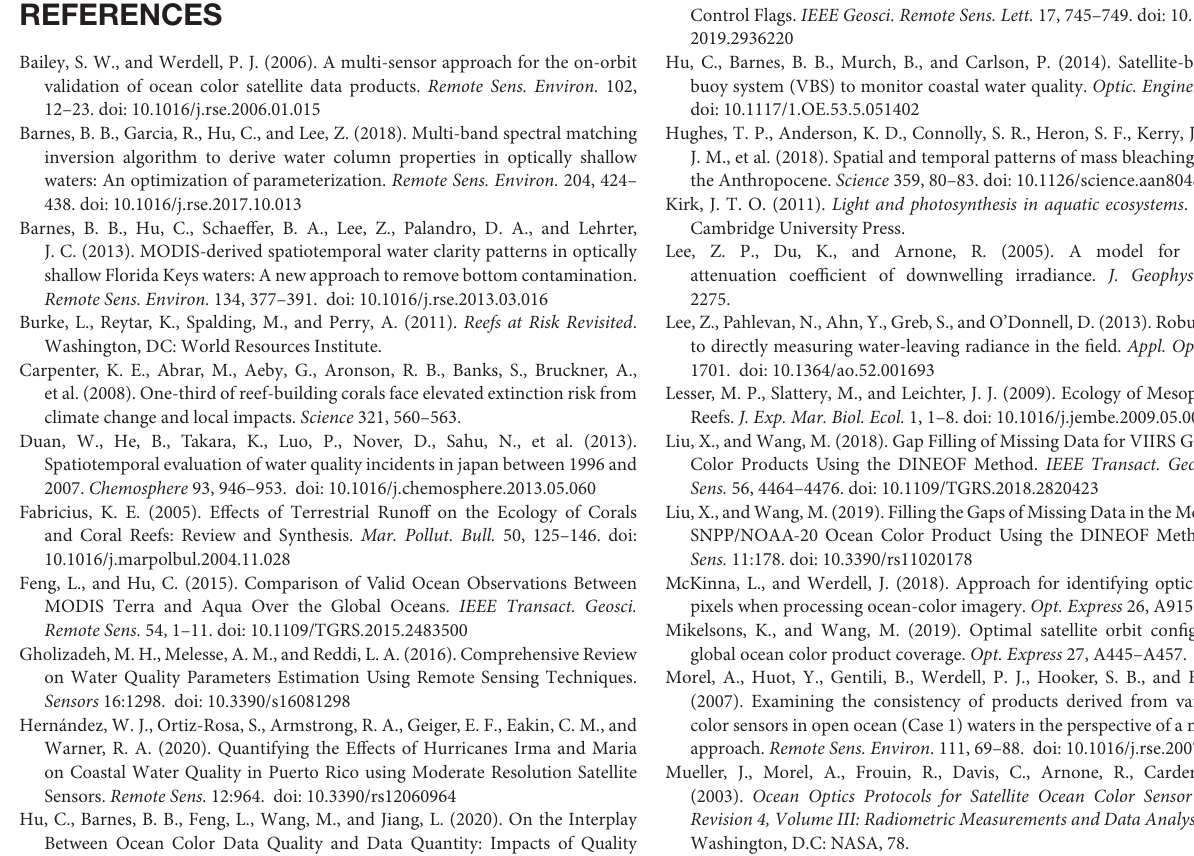
values are compiled (gray circles) and the median of those is calculated. Shading of each plot represents the RRMSE value of individual regression lines between the median satellite observation and the in situ observations. Scatterplots with two or fewer matchups are excluded. For each scatterplot, the horizontal axis values are the in situ observations from the site in Figure 3 , which were taken between 2016 and 2019, and the vertical axis values are all satellite observations associated with that in situ measurement within the time window and space buffer indicated. The number in the upper left corner is the RRMSE value for that plot; the number in the bottom right corner is the total number of satellite observations (gray circles) displayed in the plot. (B) Enlarged scatterplot for recommended spatiotemporal aggregation (13-pixels, 13-days). Axis tick values in (B) are the same as all scatterplots in (A) and major tick marks are bold for all scatterplots. Supplementary Table 1 | Site names, locations, and average depths of in situ measurement sites. The date the Maui samples were taken is November 28, 2018 and the date of the La Parguera sample is December 6, 2017. Apparent optical depth was calculated using the formula 1.3/K d (Bailey and Werdell, 2006). Rows with a gray background are considered optically shallow since the apparent optical depth exceeds the site average depth. Supplementary Table 2 | West Maui, HI sites where in situ turbidity samples were taken sorted by descending latitude as they appear in Figure 4 . N Observations is the total number of in situ observations, Matched Pairs is the number of in situ observations with corresponding satellite observations (within the 5-pixels, 7-days data cube), and Distance to Satellite Pixel is the distance of the in situ observation to the center point of the 750 m satellite pixel containing the sampling site (decimal degrees). Supplementary Table 3 | List of Level-2 flags used for quality control during the binning process and corresponding bit values that make up the bitmask for flagging